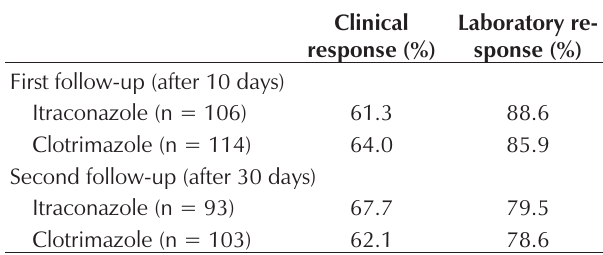
Patient demographics